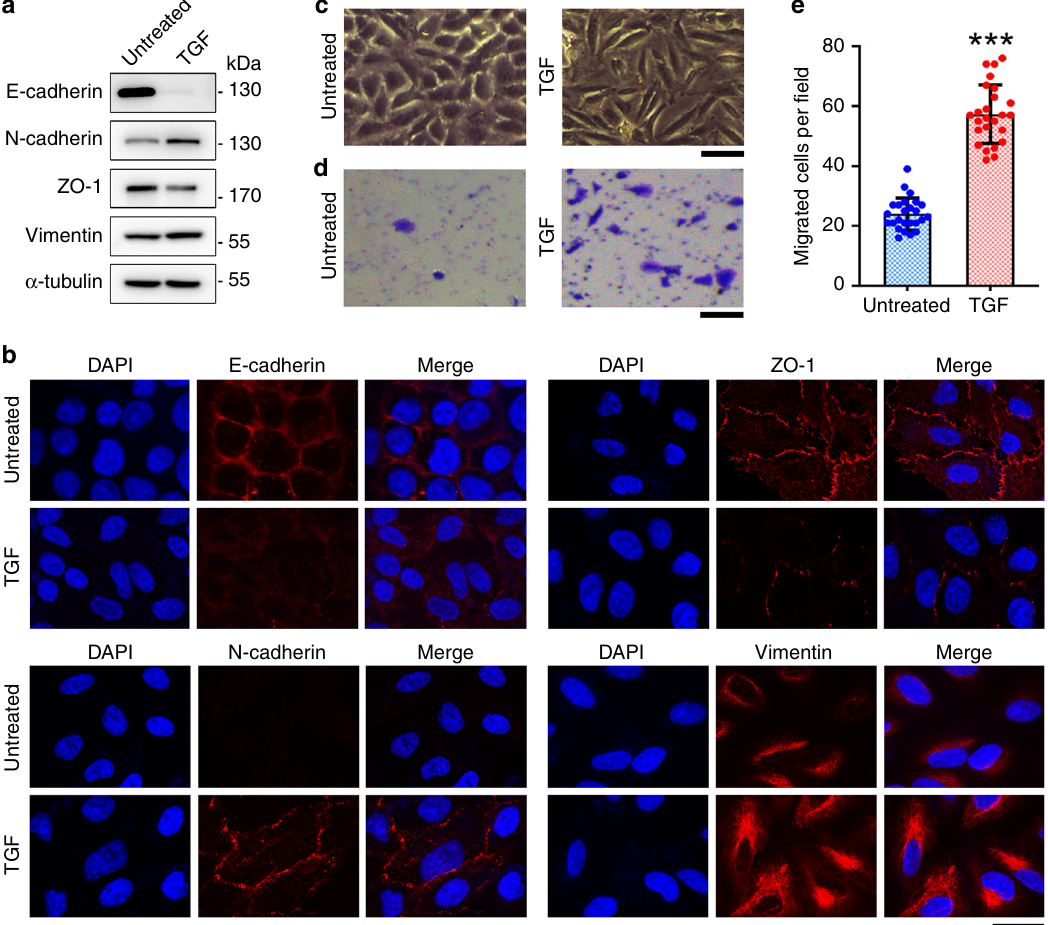
Fig. 1 Establishment of the EMT model. a A549 cells treated or untreated with TGF were analyzed by immunoblotting with E-cadherin, N-cadherin, ZO-1, vimentin, and α -tubulin antibodies. b Examination of E-cadherin, N-cadherin, ZO-1, and vimentin by immuno fl uorescence microscopy. Scale bar, 20 μ m. c Bright fi eld images of A549 cells treated or untreated with TGF. Scale bar, 100 μ m. d Transwell migration assays with A549 cells treated or untreated with TGF. Scale bar, 100 μ m. e Analysis of the number of migrated cells in the visual fi eld. *** p < 0.001 by Student ’ s t test. Error bars represent ± s.d. ( n = 25). Source data are provided as a Source Data fi